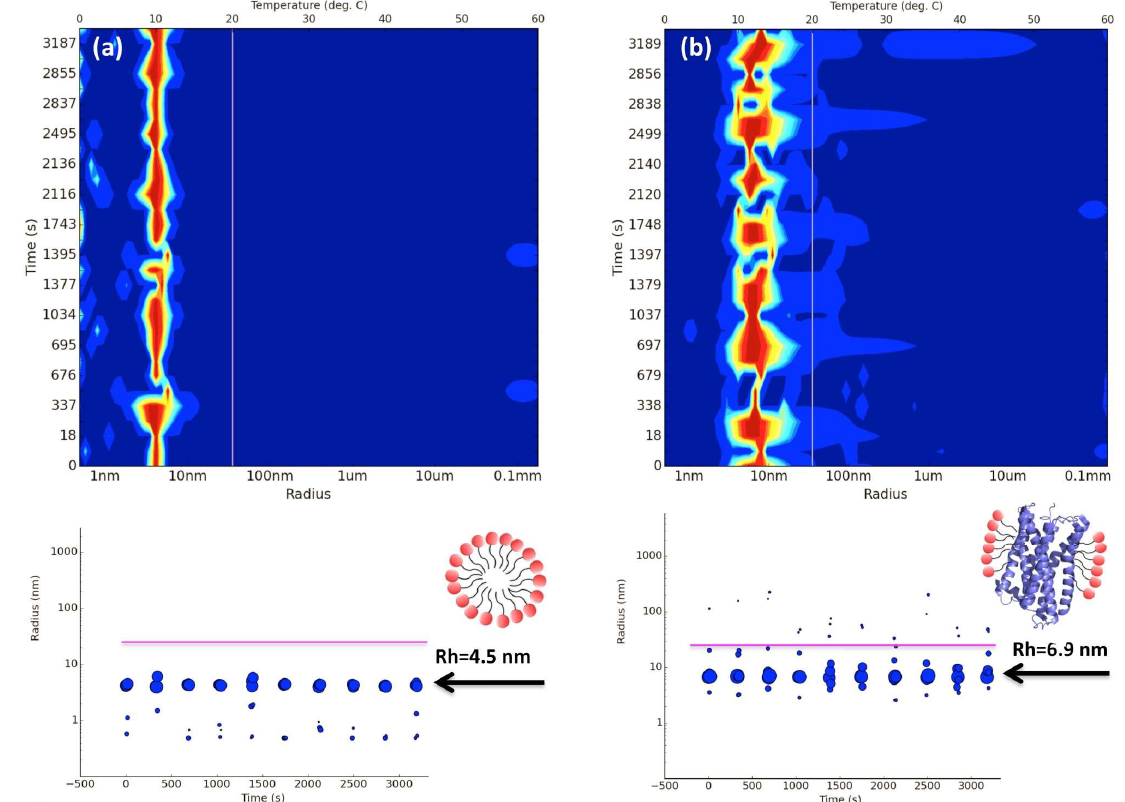
Figure 2. Example of protein detergent complex (PDC) identification based on “empty” micelle ( a ) and the same detergent solution in the presence of a membrane protein ( b ). The protein tested was a G-protein-coupled receptor (GPCR) solubilised and purified in 0.03% n-Dodecyl β- D -maltoside (DDM). Results from the dynamic light scattering (DLS) measurements show that hydrodynamic radius (Rh) of the pure DDM micelles is around 4.5 nm while the PDC micelle is around 6.9 nm. The in situ DLS experiments were carried out at 293 K using a SpectroLight 610 (XtalConcepts GmbH, Hamburg, Germany) instrument. 2 μL of each sample were pipetted onto a 72-well Terasaki plate and covered with paraffin oil. The experiments ran according to the hardware specifications of the instrument. The top radius distribution plots are shown in the form of signal heat maps (blue = low particle concentration, red = high particle concentration).